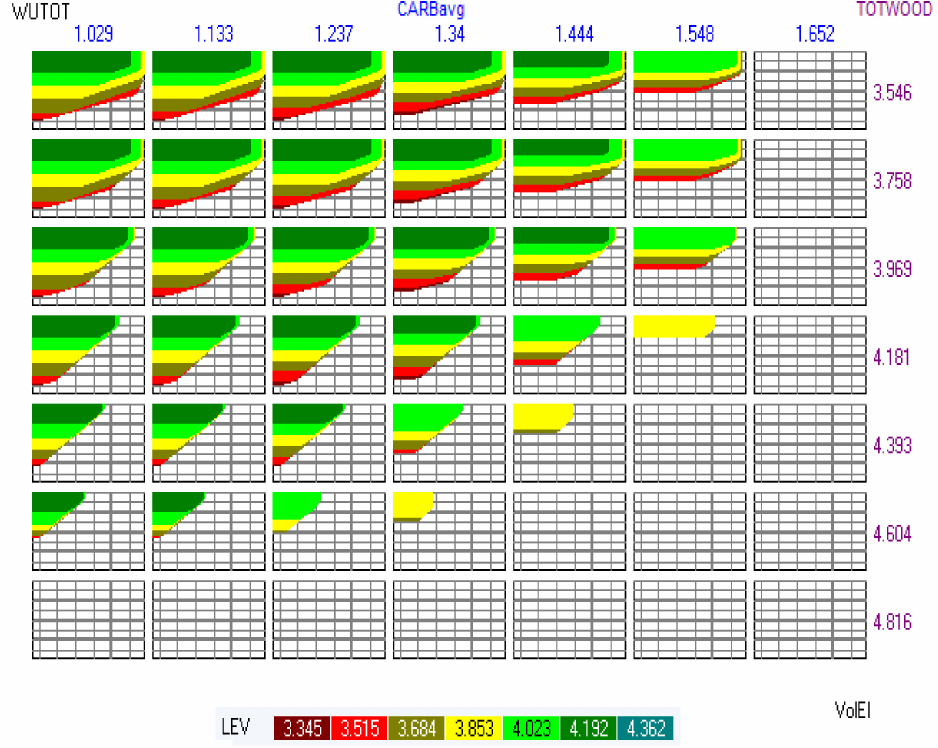
Figure 6. Set of five-dimensional decision maps showing the tradeoffs between total water use (WUTOT, 10 8 m 3 ), aboveground carbon stock (CARBavg, 10 7 kg), total harvested wood (TOTWOOD, 10 5 m 3 ),volume of ending inventory (VolEI, 10 5 m 3 ) and land expectation value (LEV, 10 9